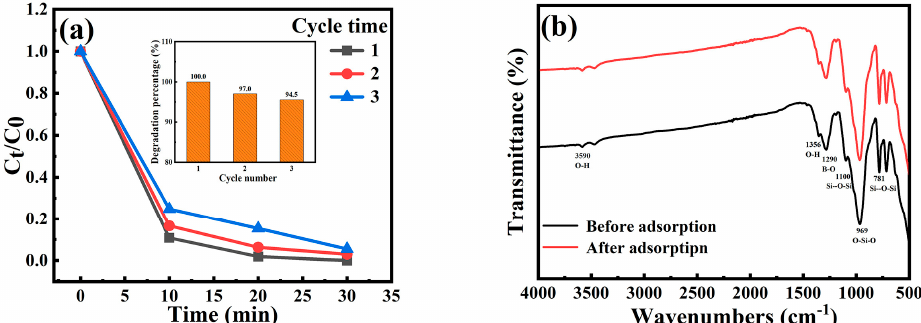
Figure 4. ( a ) Recycling utilization tests with elbaite. ( b ) FTIR spectra of powdered elbaite before reaction and after reaction reaction and after reaction of the elbaite/H 2 O 2 system. Experimental conditions: RhB = 100 mg/L, of the elbaite/H 2 O 2 system. Experimental conditions: RhB = 100 mg/L, elbaite dose = 4.0 g/L, H 2 O 2 dose = 7.0 mL/L, initial elbaite dose = 4.0 g/L, H 2 O 2 dose = 7.0 mL/L, initial pH = 2.0, T = 30 ◦ C–80 ◦ C, time = 30 pH = 2.0, T = 30 °C–80 °C, time = 30 min.